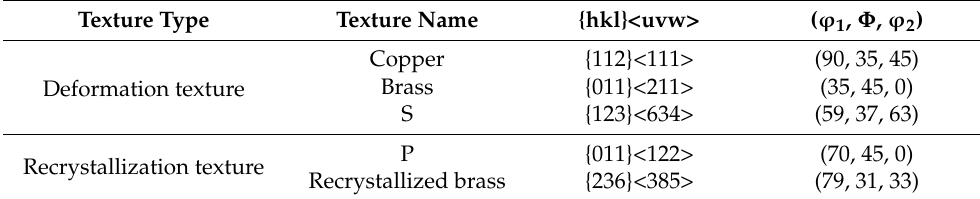
Figure 8. Orientation distribution function (ODF) maps where ϕ 2 is a constant value and the interval of the 2A14 Al alloy is 5°: ( a ) hot-rolled, annealed to ( b ) 505 °C, ( c ) 555 °C, and ( d ) 580 °C. Table 2. Main textures of the hot-rolled 2A14 Al alloy